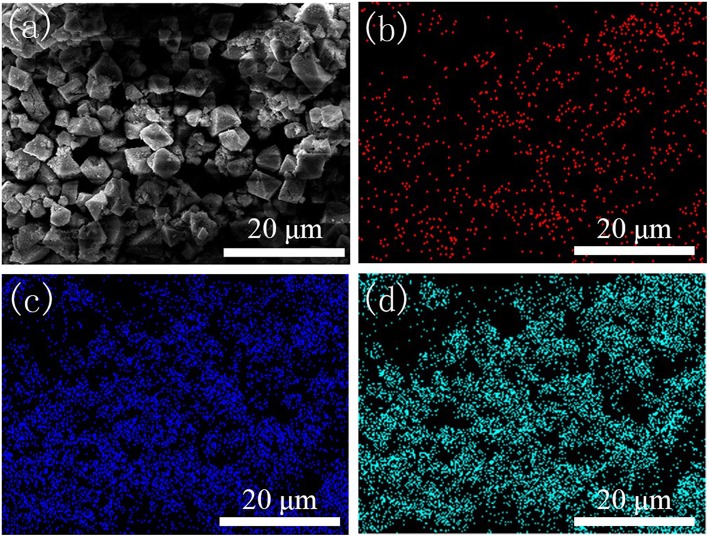
EDS mapping of Fe-HK-2 sample. SEM image (a) and the corresponding elemental distributions of Fe (b), Cu (c), and O (d).